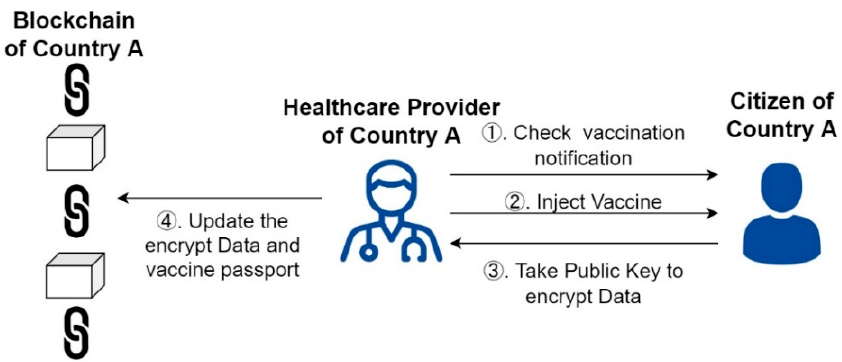
Figure 5. Scenario of the first dose of vaccine.